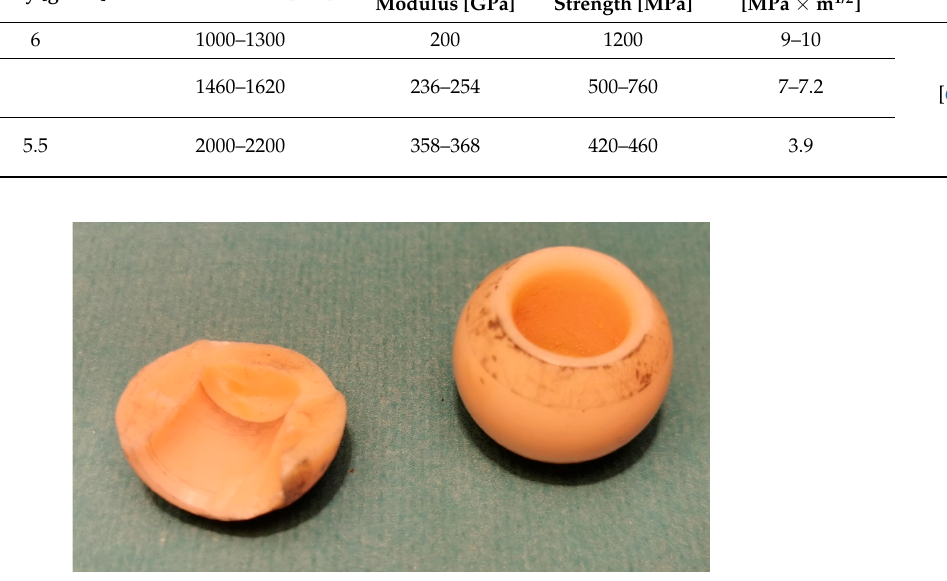
Figure 2. Fragmentation (break) of ceramic head of the hip prosthesis that succumbed to accidental overload with mechanical forces of high